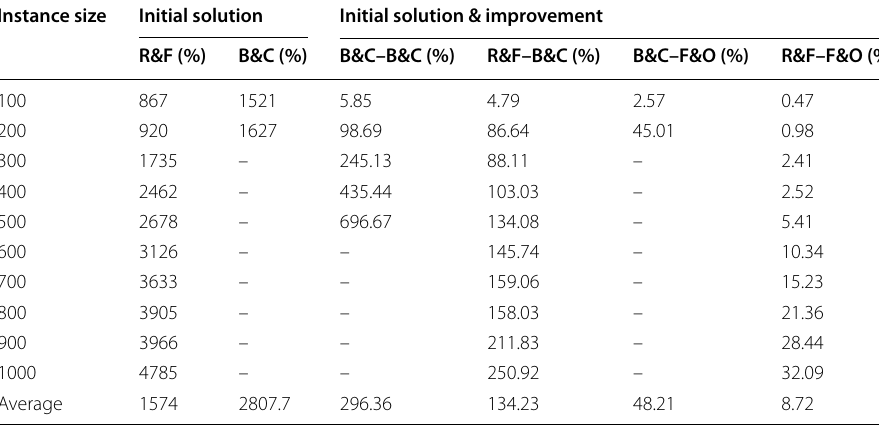
Table 1 Optimality gap for the heuristic approaches Instance